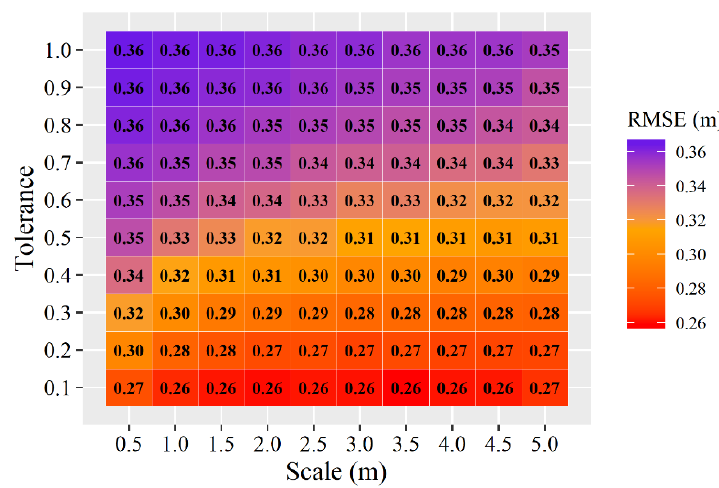
Figure 4. Root mean square error (RMSE) values of the digital terrain models (DTMs) derived from the calibration of the parameters of the multiscale curvature classification (MCC).